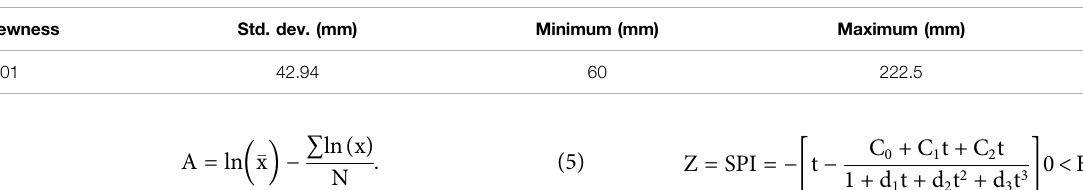
TABLE 1 | Statistical data of annual rainfall time series (1973 –